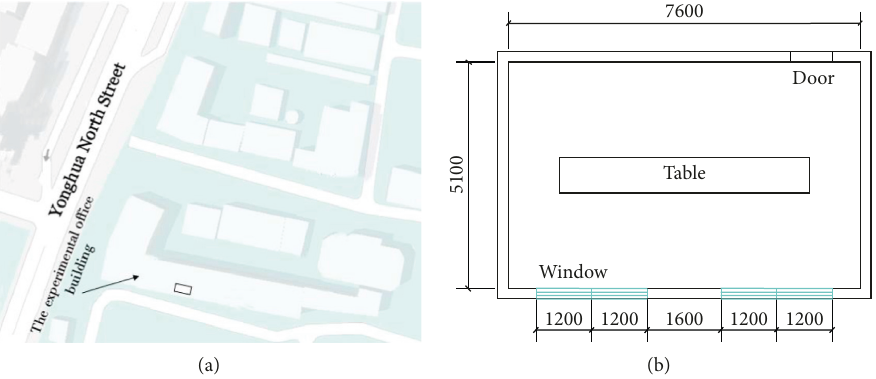
Figure 1: (a) The landscape of the building and (b) the layout of the experiment